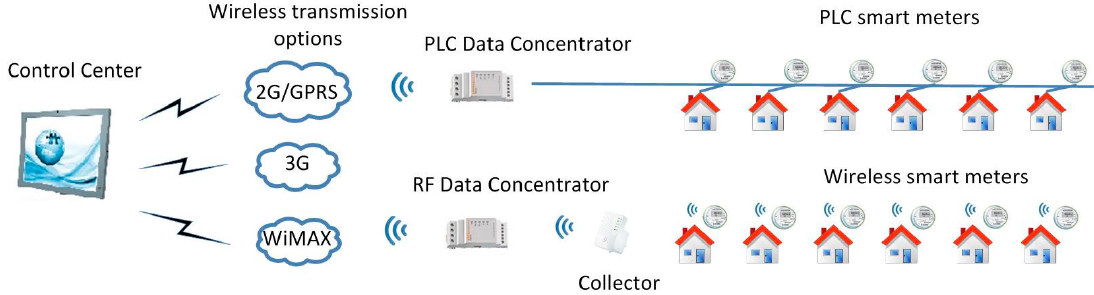
Figure 1. AMI—Communication from the smart meters to the utility system with several technological